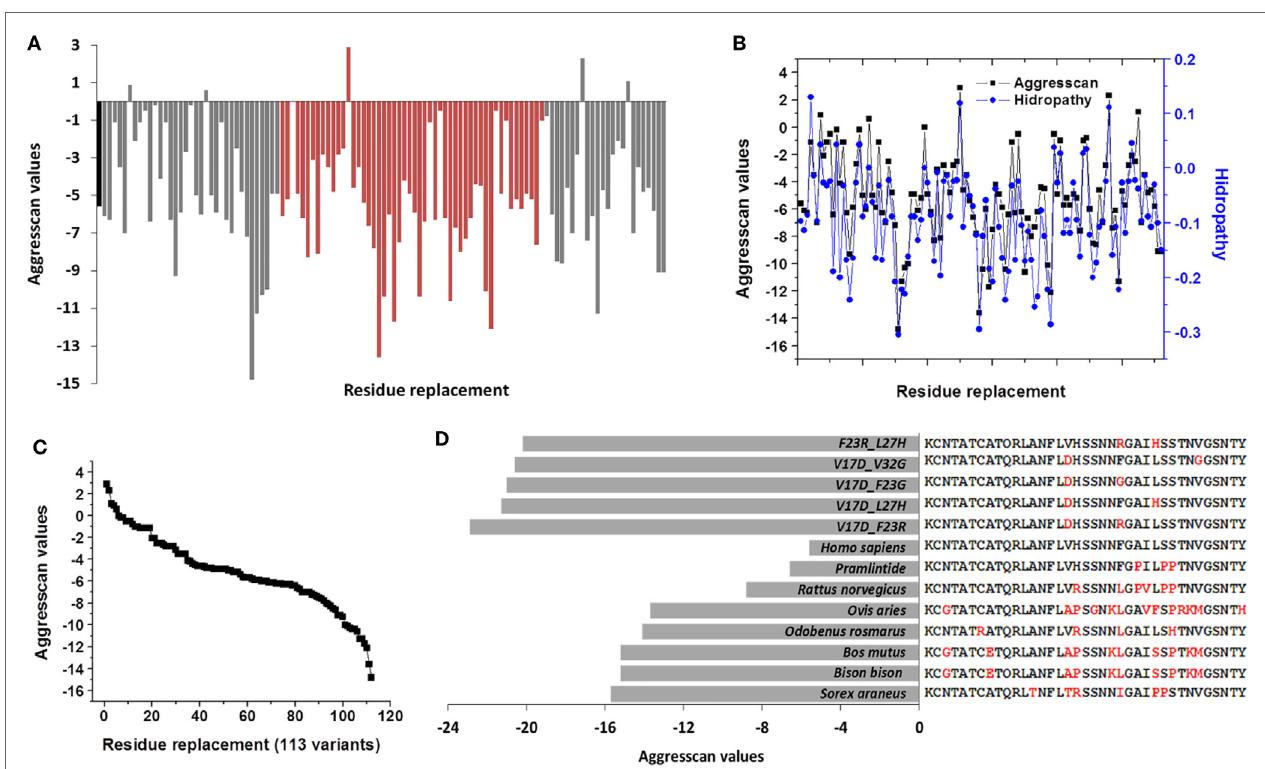
FigUre 2 | Single modifications on hIAPP could originate 113 de novo sequences that modulate the amyloid aggregation in islet amyloid polypeptide. (a) Effect of residue substitution on the hIAPP (residues 1–37), showed by the Aggrescan values. Orange variants in regions 17–31 are identified; black bar corresponds to hIAPP. (B) Association of hydropathy and Aggrescan values of 113 de novo variants. (c) Sigmoidal trend was registered in aggregation values of 113 de novo variants . (D) Sequences of species with low aggregation tendency in contrast to less aggregative sequences de novo with two substitutions. hIAPP was used as a reference, in red, were identified the